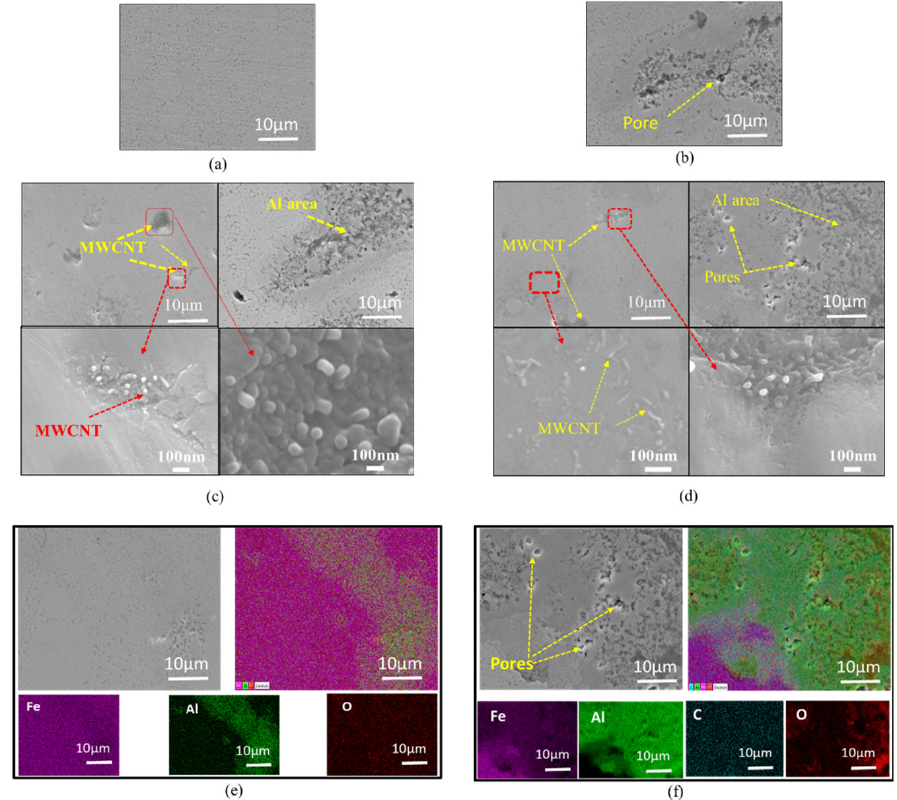
Figure 3. Morphology of the sintered composites: ( a ) SEM images of pure Fe (sintered nFe); ( b ) SEM images of 80nFe-20Al; ( c ) SEM images of 80nFe-19Al-1MWCNT; ( d ) SEM images of 80nFe-18Al-2WMCNT; ( e ) EDS mapping of 80nFe-20Al and ( f ) EDS mapping of 80nFe-18Al-2WMCNT.